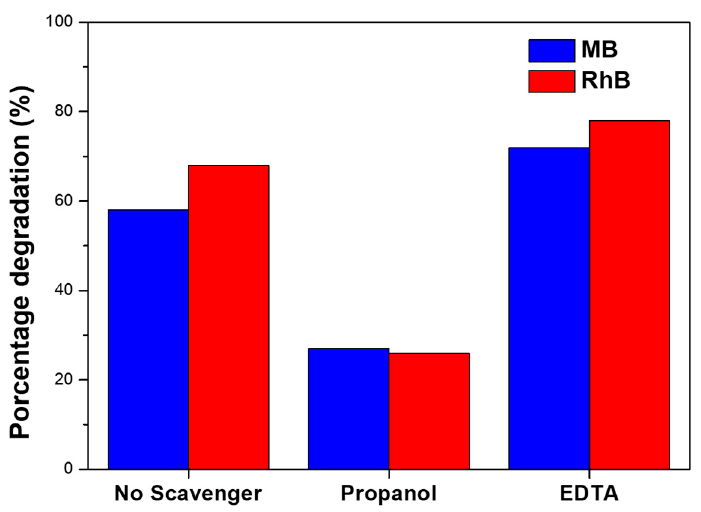
Figure 7. Effects of scavenger on MB and RhB photodegradation by ZnS nanoparticles.